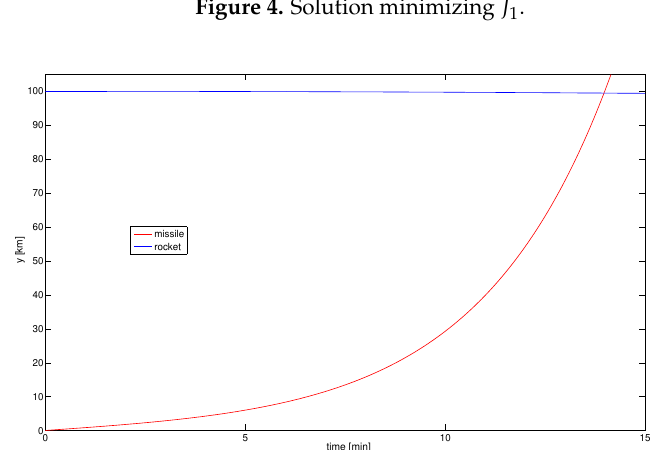
Figure 4. Solution minimizing J 1 .